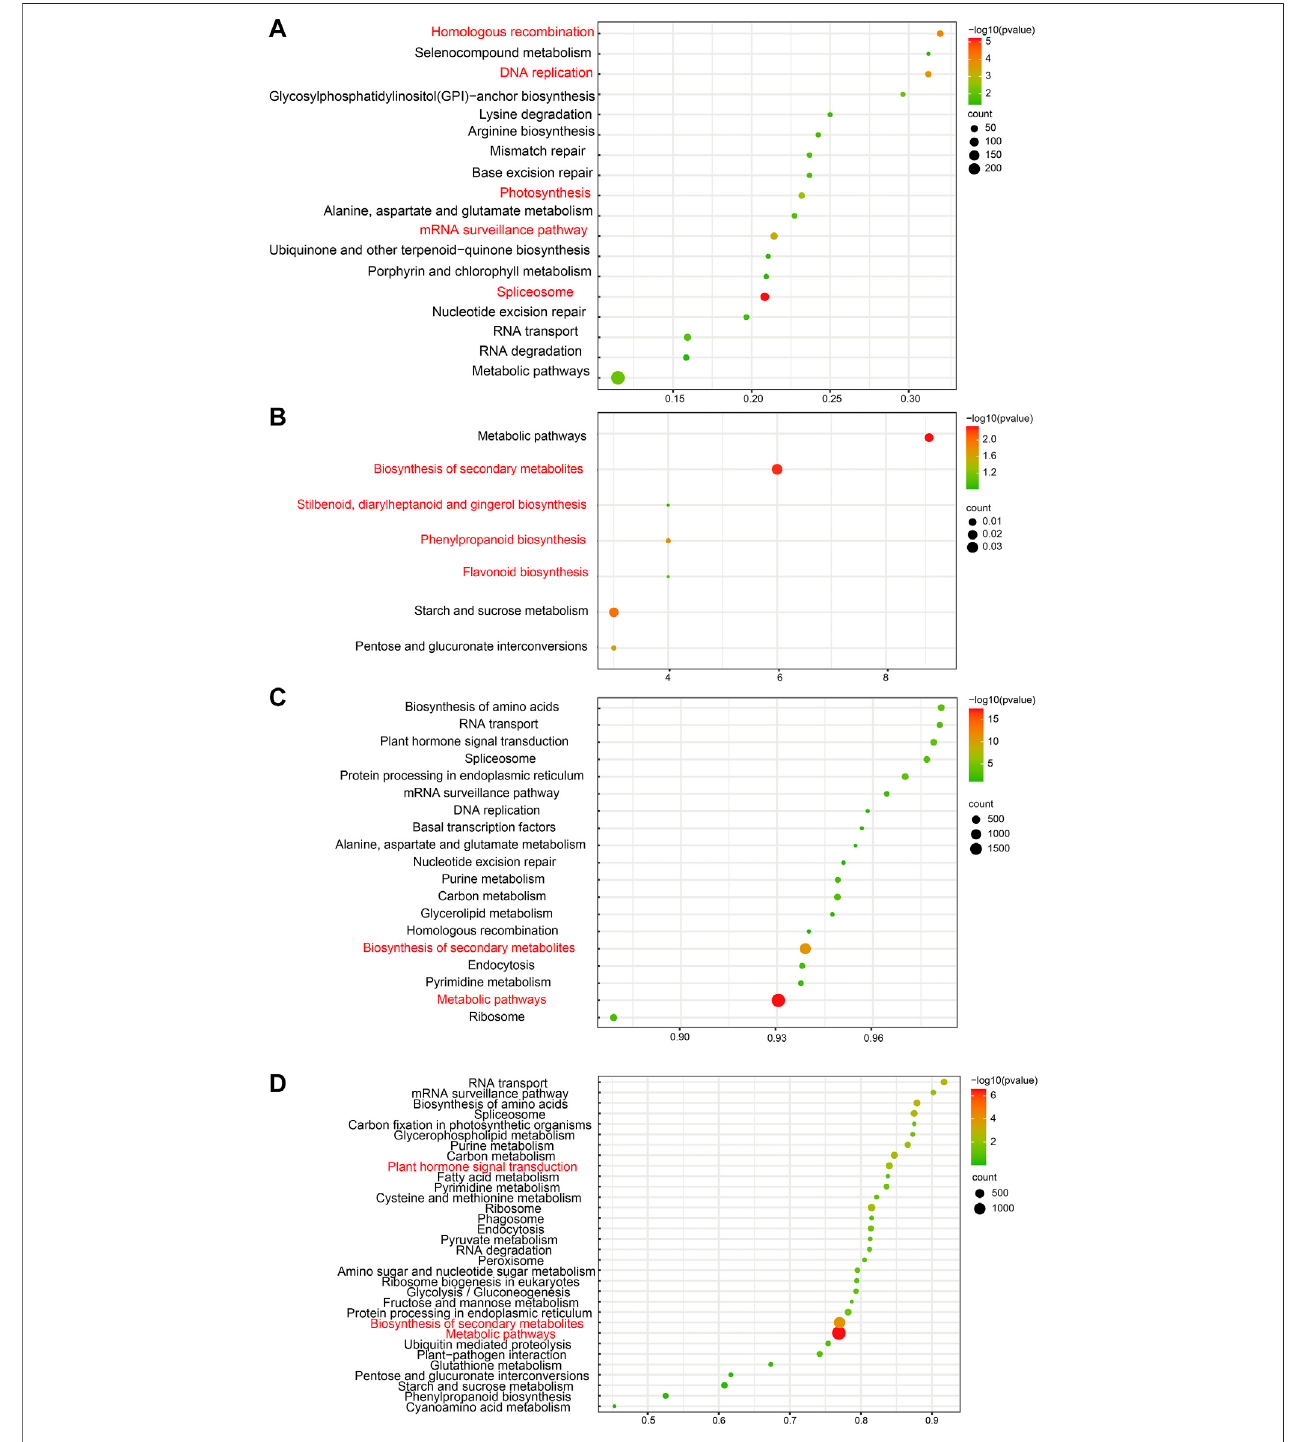
FIGURE 3 | Common and unique enriched KEGG pathways of four developmental stages. (A) Common enriched KEGG pathways of four stages with trans- regulationfunction. (B) CommonenrichedKEGGpathwaysoffourstageswithcis-regulationfunction. (C) UniqueenrichedGOtermsoffourstageswithtrans-regulation function. (D) Unique enriched GO terms of four stages with cis-regulation function.